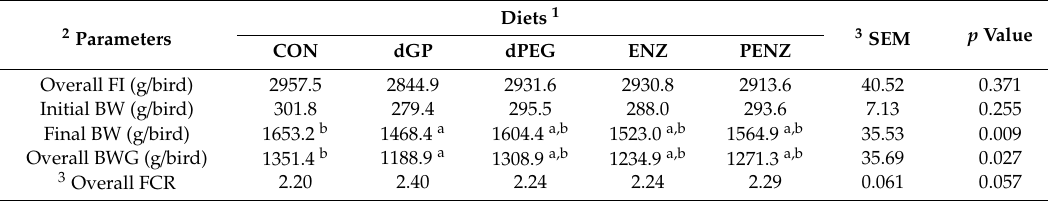
Table 3. E ff ect of treating red grape pomace with polyethylene glycol and a cellulolytic enzyme mixture on overall feed intake (14–42 d), initial body weight (14 d), final body weight (42 d), and overall body weight gain (14–42 d) and the overall feed conversion ratio (14–42 d) of broiler